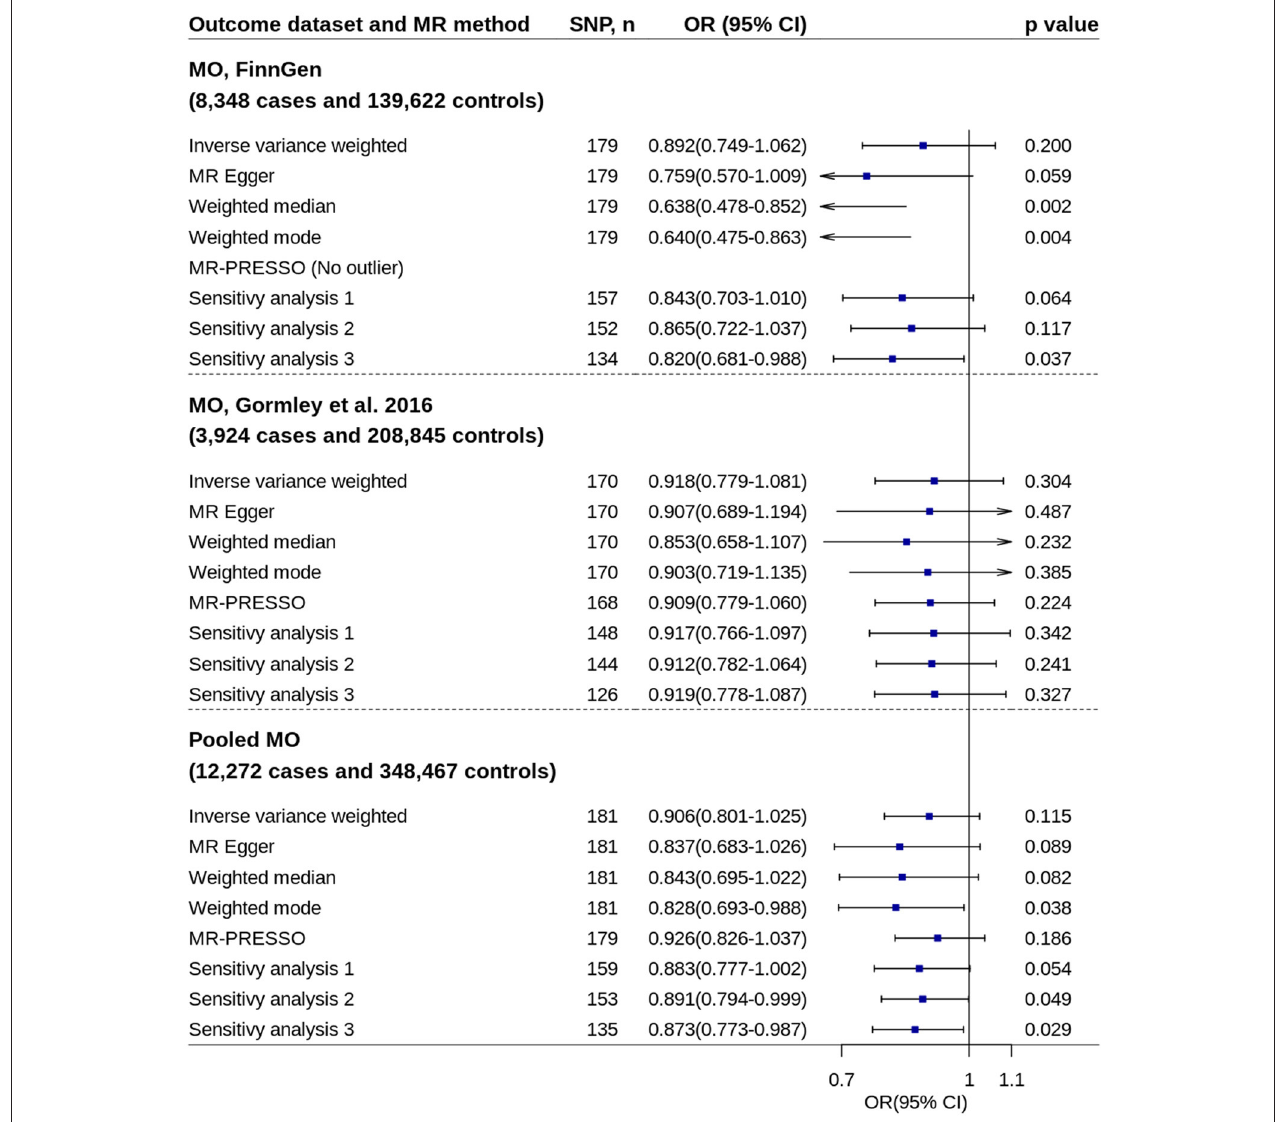
FIGURE 6 | Mendelian randomization analyses of 25OHD on risk of migraine without aura. Sensitivity analysis 1: SNPs associated with potential confounders were excluded. Sensitivity analysis 2: Potential reverse causal SNPs were excluded (Steiger-filtered analysis). Sensitivity analysis 3: All SNPs excluded in sensitivity analysis 1 and sensitivity analysis 2 were excluded. 25OHD, 25-hydroxyvitamin D; CI, confidence interval; MO, migraine without aura; MR, Mendelian randomization; MR-PRESSO, MR-Pleiotropy Residual Sum and Outlier; OR, odds ratio; SNP, single nucleotide